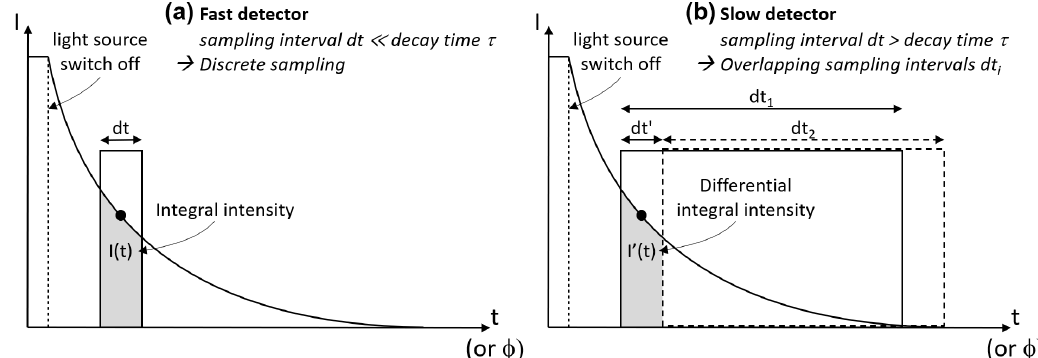
Figure 3. Sampling of temporal evolution using fast and slow detectors. In conventional sampling (a) , a fast detector with a sampling interval shorter than the characteristic time constant allows us to sample the temporal evolution point by point. If slow detectors are used (b) , the same information can be retrieved by comparing overlapping sampling